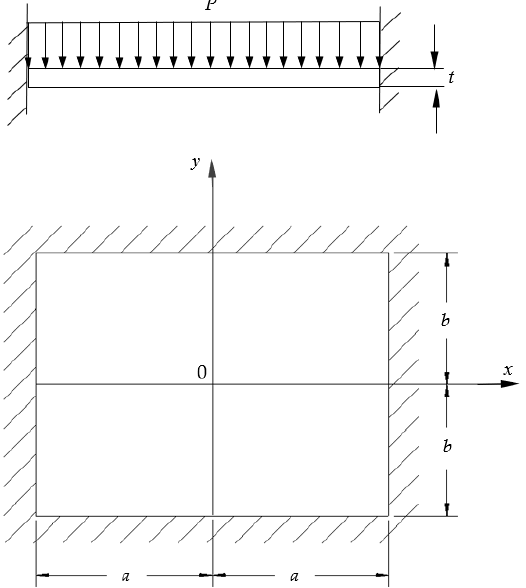
Figure 5. An isotropic elastic rectangular plate with clamped edges under lateral pressure.